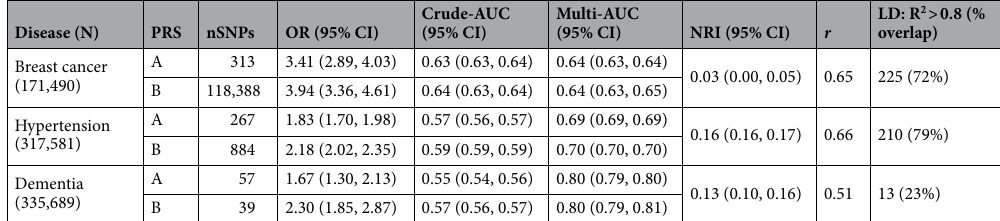
Table 2. PRS compared for each outcome and their performance characteristics in the UK Biobank. N: number of participants whose PRS score was obtained. nSNPs: number of SNPs in PRS prior to genetic quality control. OR: odds ratio for top 1% versus middle quintile of PRS from multivariable logistic regression model adjusted for age, sex, genotyping array and first 5 PCs. AUC: area under receiver-operating curve. Crude-AUC: only continuous PRS was fitted in a regression model. Multi-AUC: continuous PRS was fitted, further adjusted for age and sex. NRI: continuous net reclassification index obtained from predicted risks by two multivariable logistic regression models that contain age, sex, continuous PRS for this disease, genotyping array and first 5 PCs. The model containing PRS-B is considered the “updated” model. r : Pearson correlation coefficient between the two continuous PRS for this disease. LD: number (%) of SNPs in PRS-A which either appear in or are in linkage disequilibrium (R 2 > 0.8) with SNPs in PRS-B. Breast cancer models are not adjusted for sex because its population is restricted to females. 95% CI for AUC and NRI calculated by